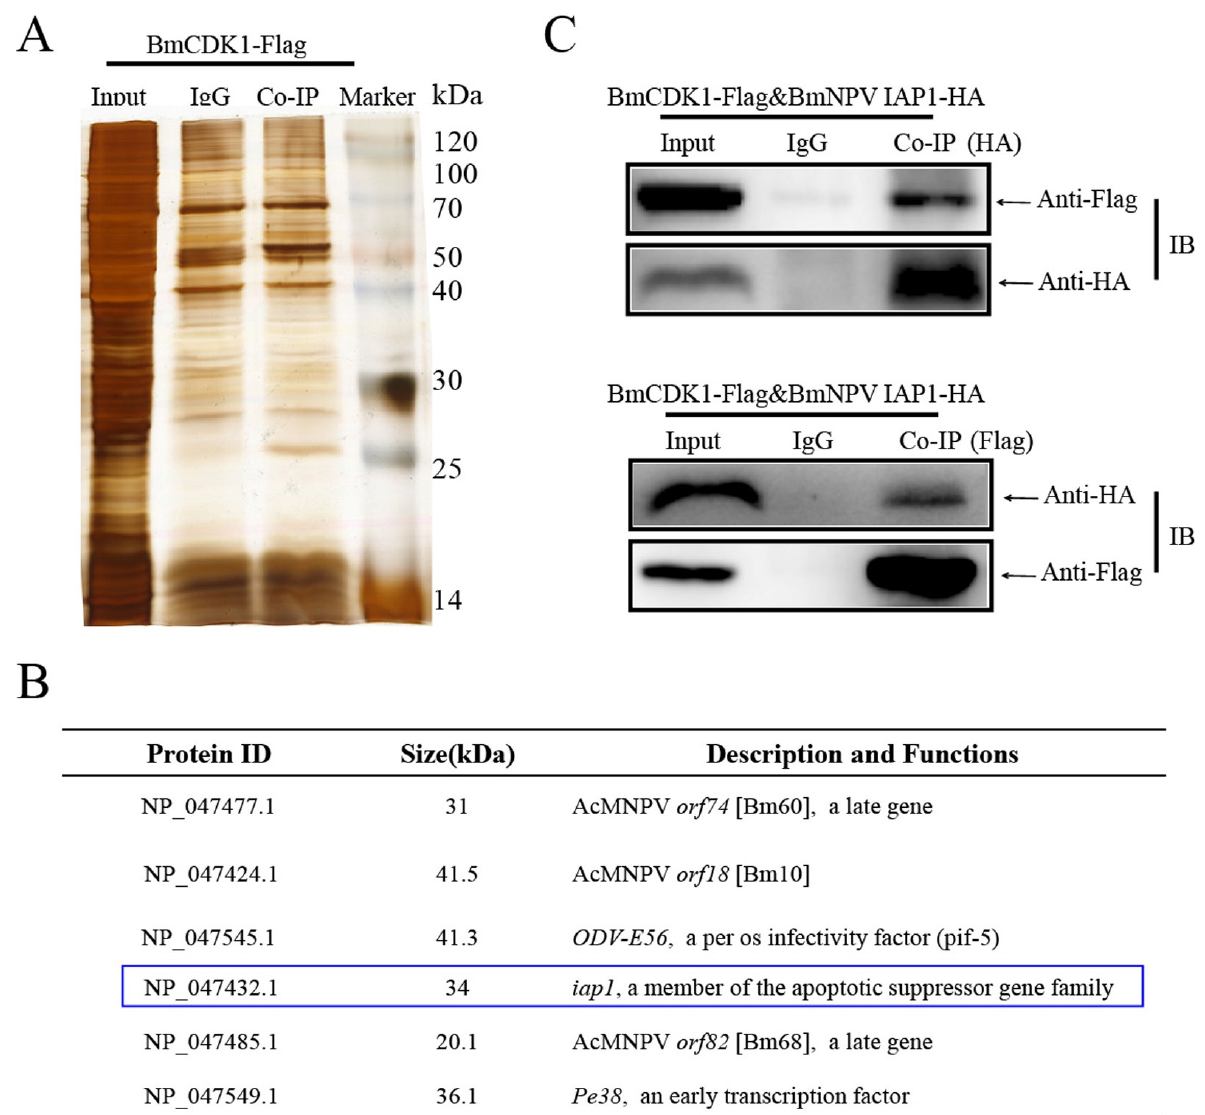
Figure 4. BmNPV IAP1 interacts with BmCDK1. ( A ) BmCDK1 was overexpressed by recombinant BmNPV (vBm- BmCDK1 ). BmN-SWU1 cells were infected with 1 MOI of vBm- BmCDK1 . Co-immunoprecipitation (Co-IP) was performed 48